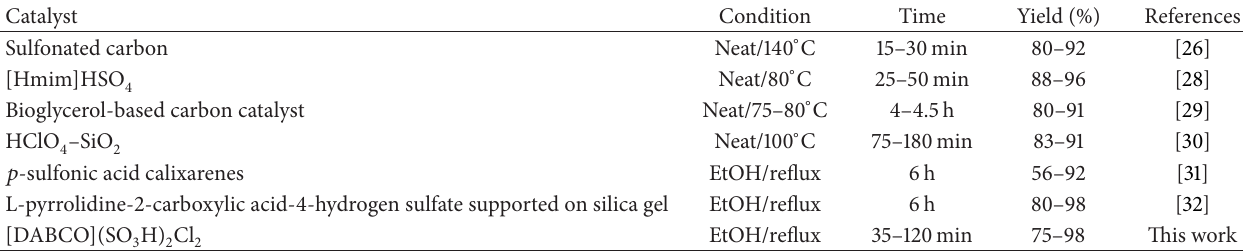
Table 2: Comparison of the results obtained for the synthesis of 3,4-dihydropyrimidine-2-(1H)-ones catalyzed by [DABCO](SO other recently reported